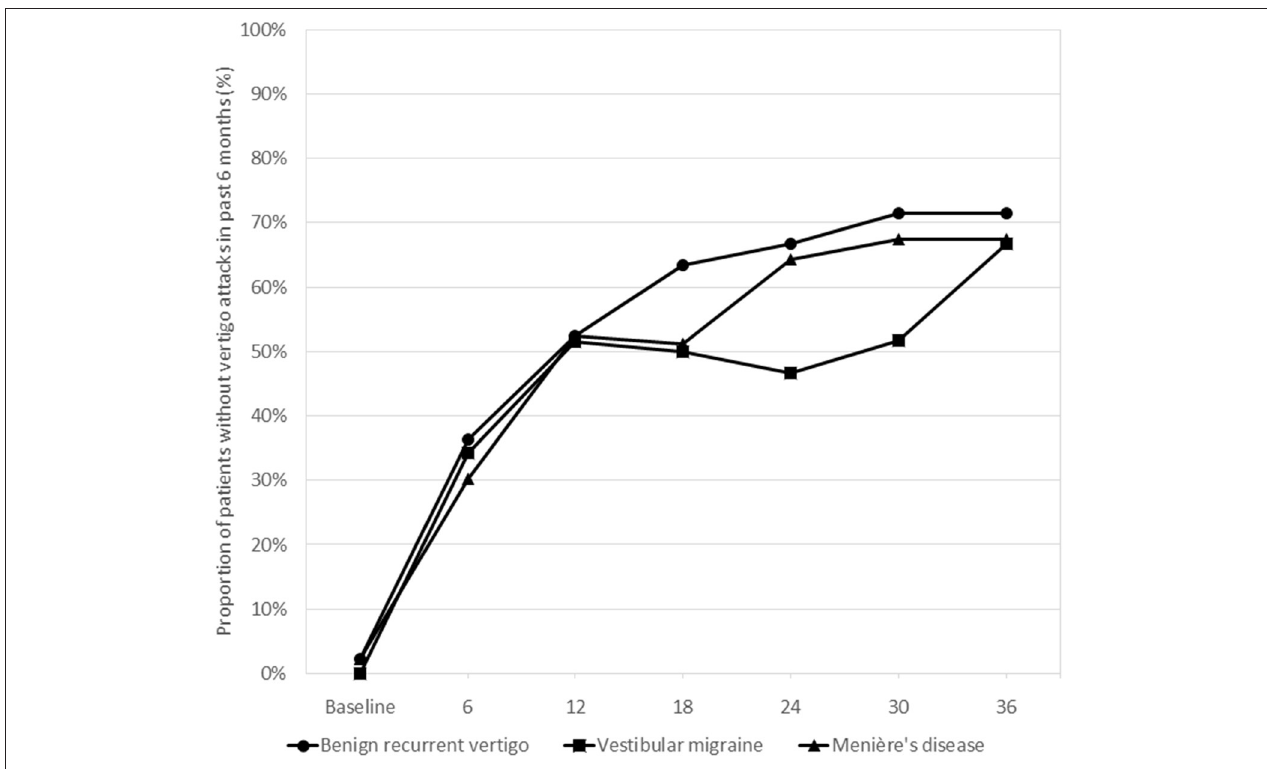
FIGURE 3 | Proportions of patients without vertigo attacks during the past 6 months as reported by the patients in the three diagnosis groups at the consecutive follow-up visits. Differences between the groups were statistically tested using generalized estimating equations models. Overall, there were no statistically significant differences between the groups for the follow-up period as a